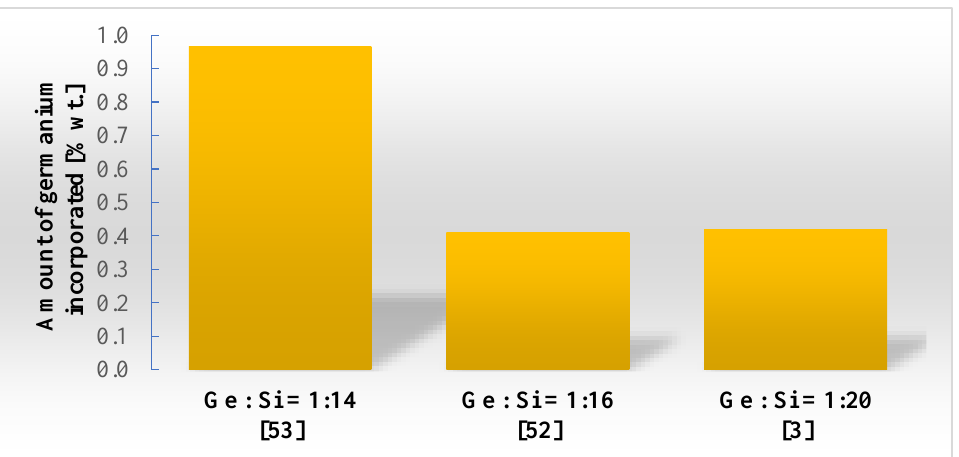
Figure 5. The dependence of the amount of germanium to silica frustule on the initial Ge:Si concentration ratio in the culture medium [3,52,53].